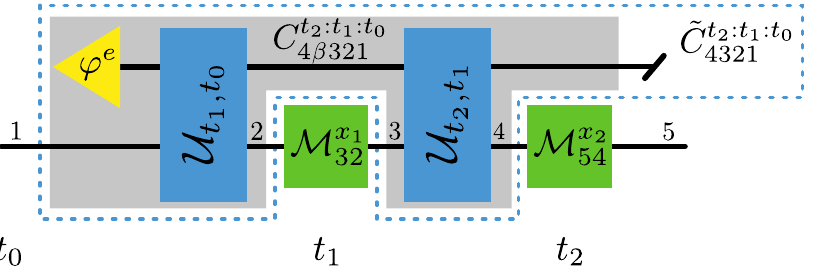
FIG. 12. Dilation for Example 1. Pictorial representation of the quantum combs describing Example 1 with two